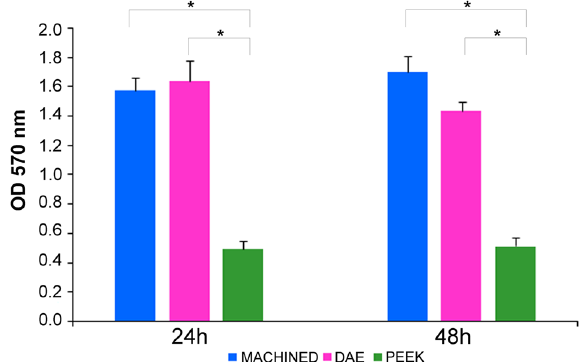
Fig. 7 Representative Live/Dead images of S. oralis adhesion on titanium discs machined, DAE and PEEK ones after 24 and 48 h of incubation (live cells appeared green, death cells were red) (* p -value < 0.05). All formed bio fi lms on different material surfaces were compared to the controls group that were the untreated samples obtained with the identical methodologies in every way except for the use of one of tested surfaces but on polystyrene surface. Original magni fi cation, 1000 X